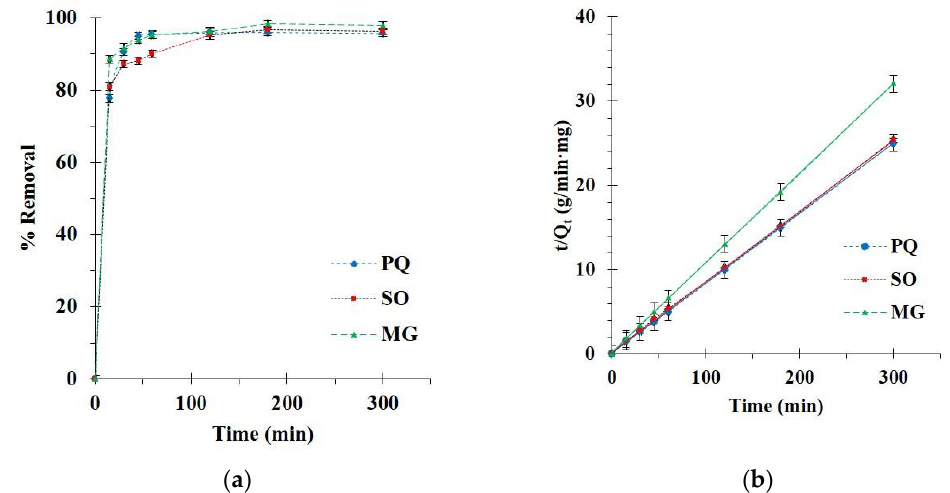
Figure 10. ( a ) Influence of contact time on adsorption capacity; ( b ) Pseudo-second-order kinetics of contaminant adsorption (conditions: 2 g/L of adsorbent dosage, 25 mg/L of PQ initial concentration, optimal, and temperature at 303 K).